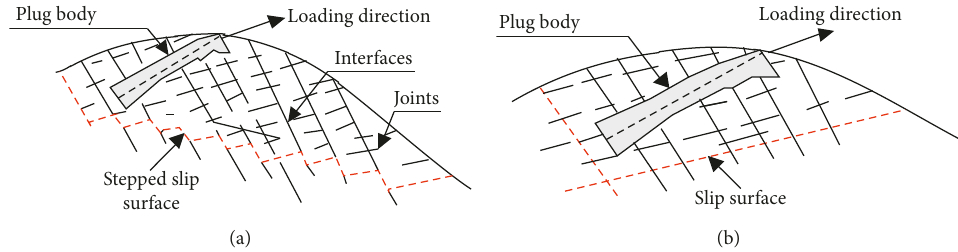
Figure 7: Slope slip failure mode. (a) Step sliding failure mode. (b) Antidip plane sliding failure mode.